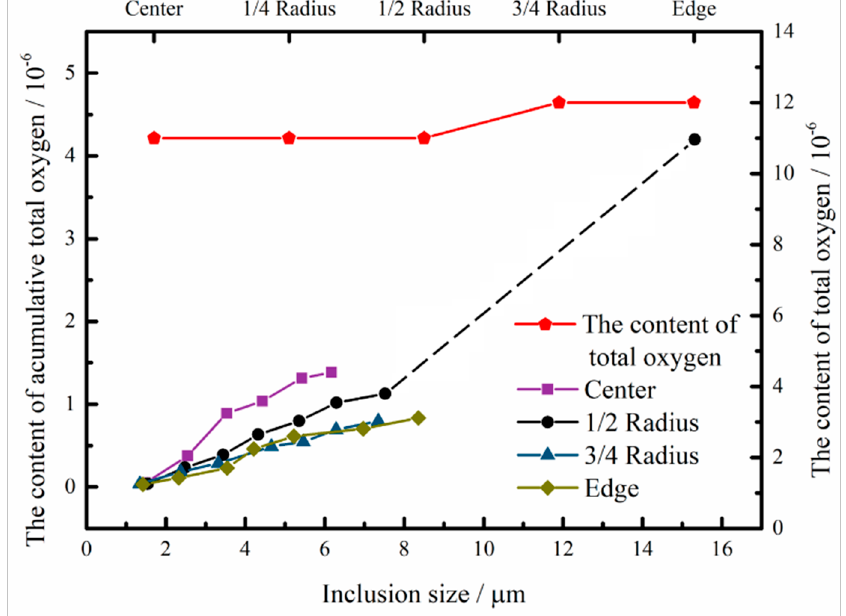
Figure 8. Relationship between oxide sizes and accumulative oxygen in oxides per unit volume.